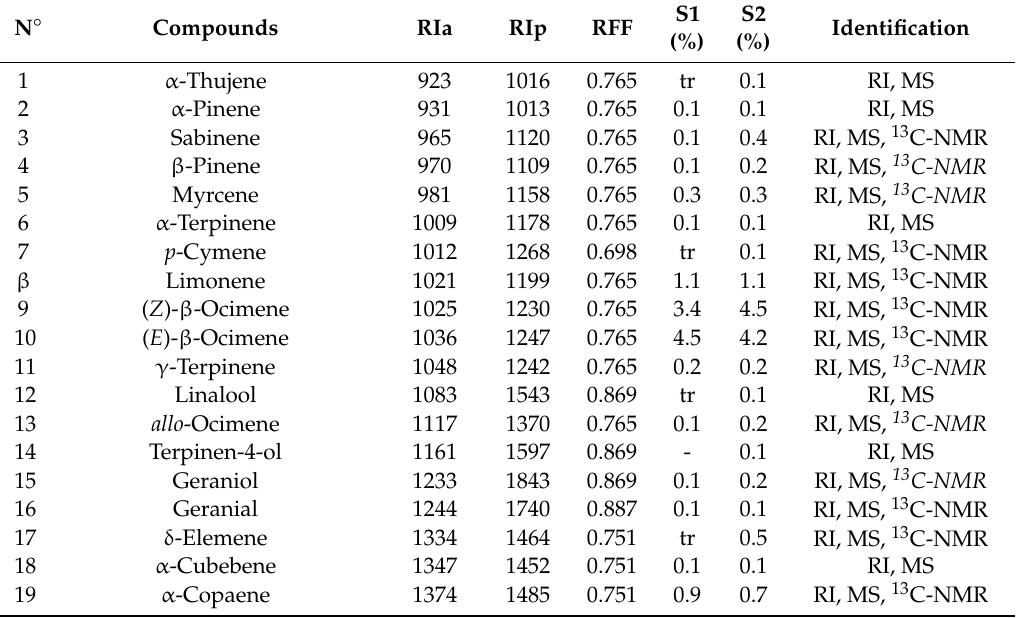
Table 4. Chemical composition of leaf essential oil from Isolona dewevrei